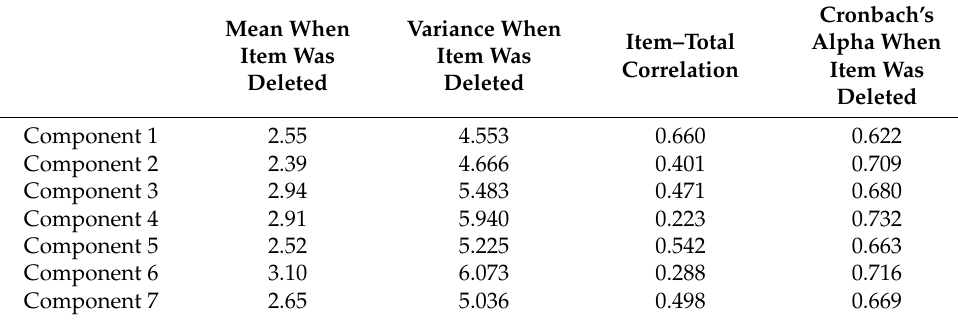
Table 2. Internal consistency: Cronbach’s alpha with item